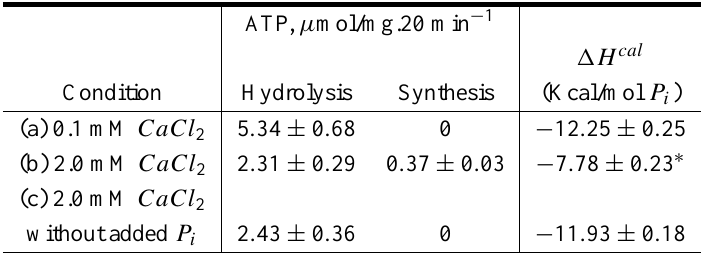
Heat released and ATP synthesis in the absence of Ca 2 +